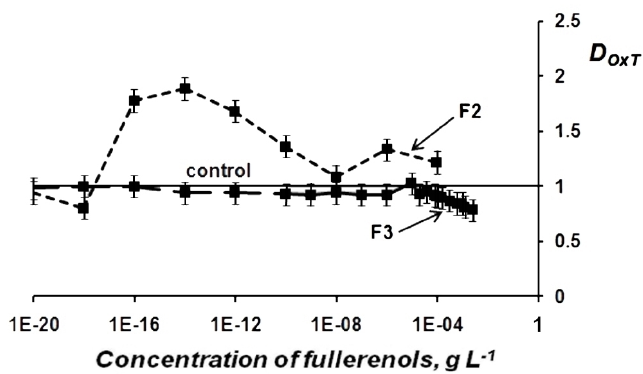
Figure 5. Detoxification coefficients D OxT vs. concentration of fullerenols F2 and F3 in solutions of 1,4-benzoquinone (10 − 4 M) for the enzyme-based assay.